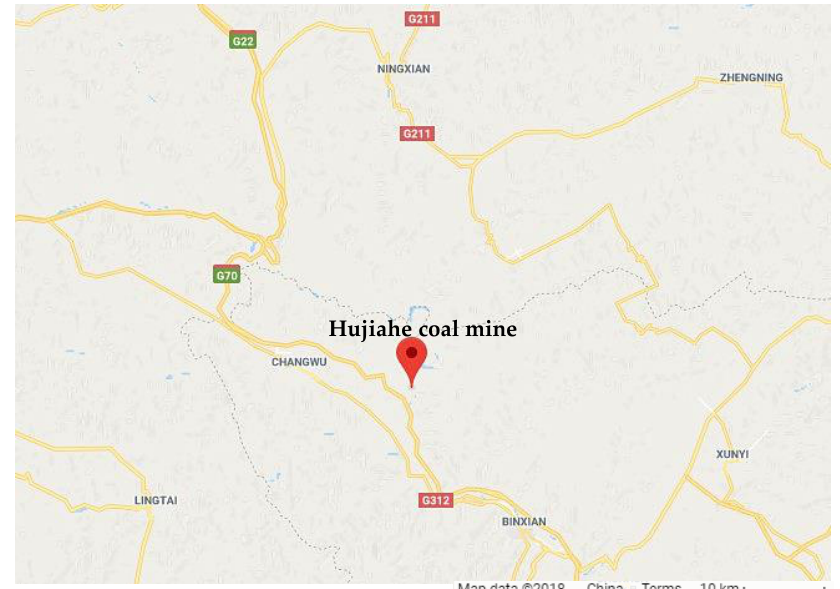
Figure 6. Location of the Hujiahe coal mine (Xianyang, Shaanxi, China). Thickness Remarks Lithology (m) Siltstone Dark grey, compact mass, phytolith rich. Clay Dark grey, consisting of farinose chiltern. Coarse-grained sandstone Medium-grained sandstone No.4 Coal Fine-grained sandstone Figure 7. Geologic column of LW402103, showing the geological information (lithology, thickness, depth, age, etc.) for roofs, coal seam and floor.